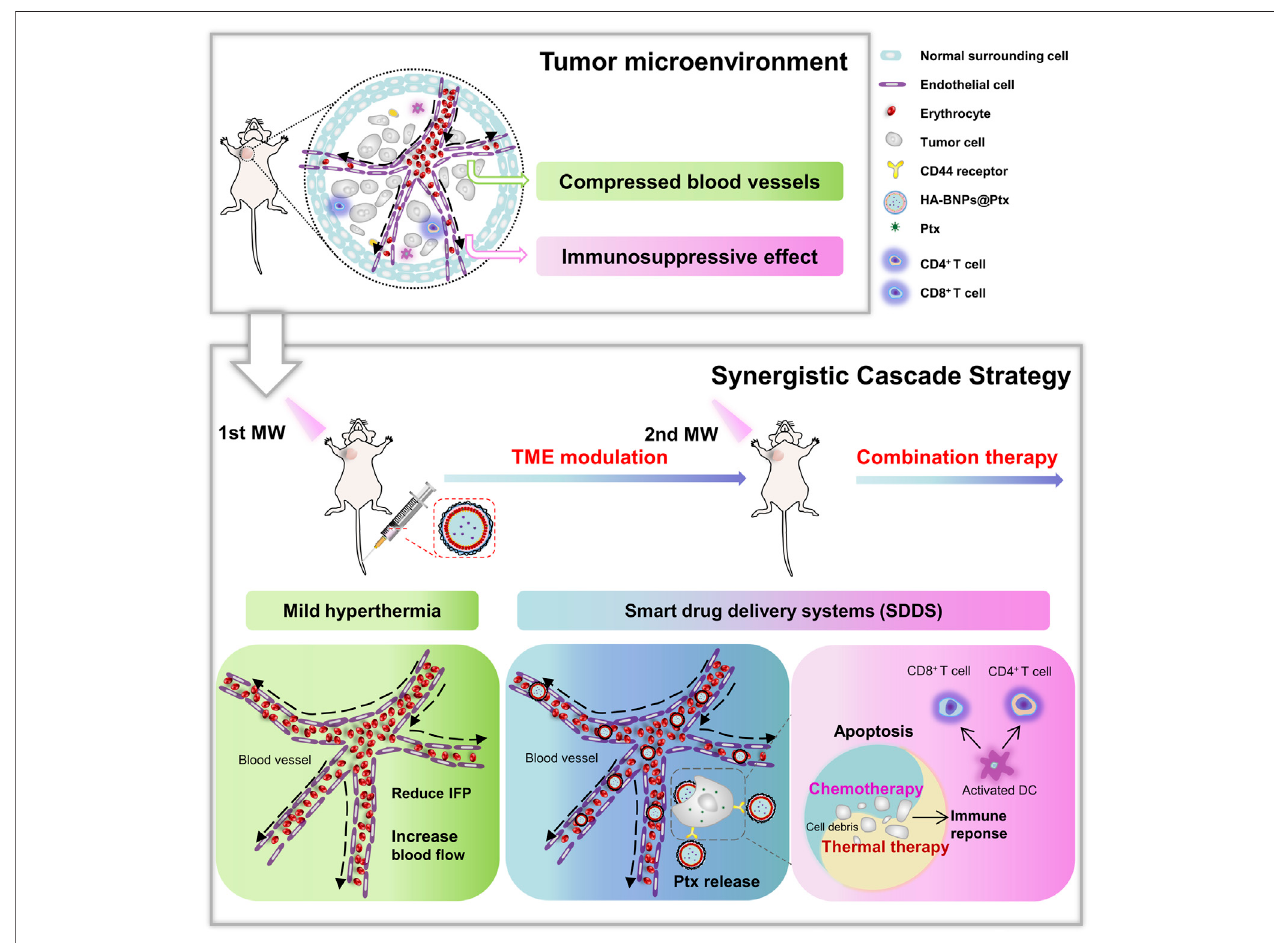
FIGURE 1 | Illustration of tumor microenvironment and treatment process with synergistic cascade strategy.